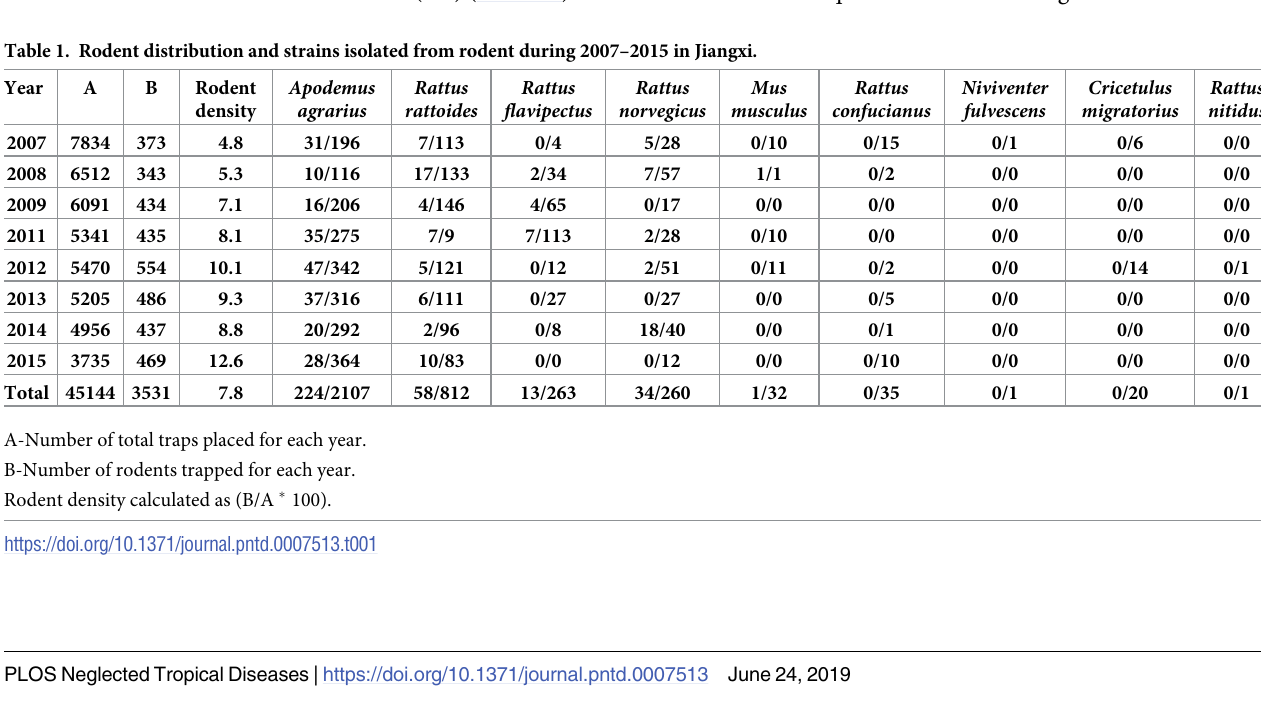
Table 1. Rodent distribution and strains isolated from rodent during 2007–2015 in Jiangxi.